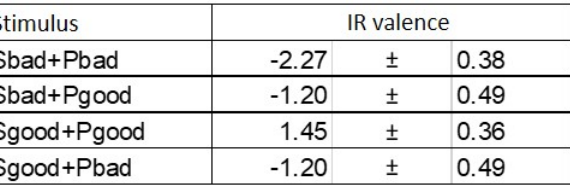
Figure 10. Comparison of the mean values of the stimuli valence in the Basic and Dissonance com- plexes. Special symbols indicate significant differences in valence according to the Wilcoxon signed − rank test: * − signi fi cant di ff erences ( p < 0.05) between the valence values associated with the presentation of stimuli Sbad + Pbad and Sbad + Pgood. ∆− signi fi cant di ff erences ( p < 0.05) between the valence values associated with the presentation of stimuli Sbad + Pbad and Sgood +